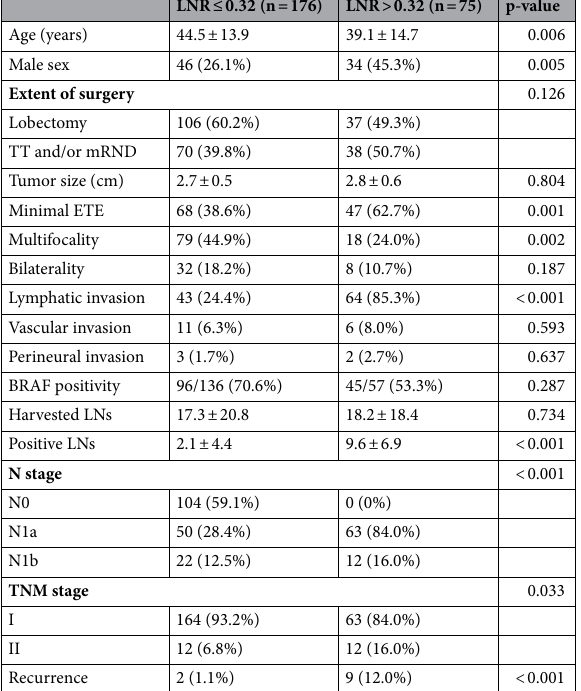
Table 5. Baseline clinicopathological characteristics according to lymph node ratio. Data were expressed as number (%) or mean ± standard deviation. A statistically significant difference was defined as p < 0.05. LNR lymph node ratio, TT total thyroidectomy, mRND modified radical neck dissection, ETE extrathyroidal extension, LN lymph node, T tumor, N node, M metastasis.